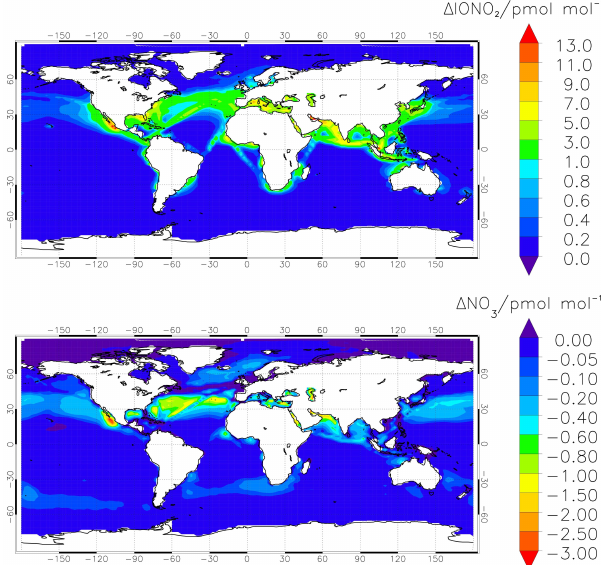
Figure 8. Modelled annual average of IONO 2 (a) and NO 3 (b) dur- ing nighttime (from 00:00 to 01:00LT) at the surface level, as the difference in volume mixing ratio between the simulations with and without Reactions (R1) and